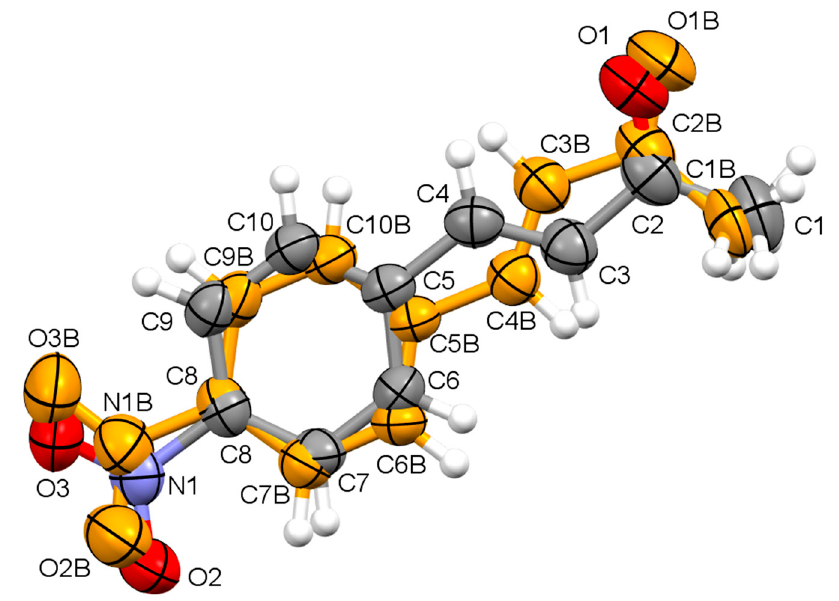
Figure 2. The ORTEP drawing of disordered compound II showing displacement ellipsoids drawn at the 50% probability level (minor conformer in orange).